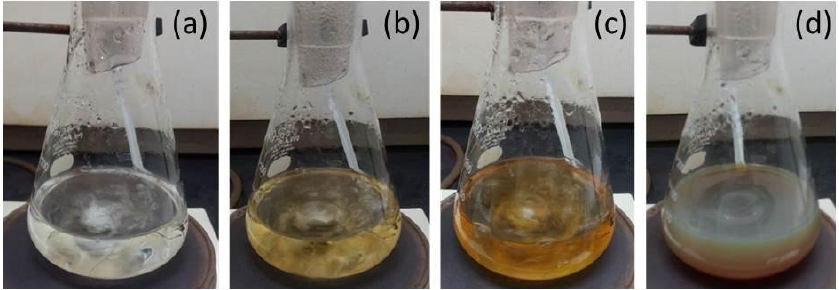
Figure 9. Color changing of sample 1 at different phases of the reaction. ( a ) Transparent color appeared on dissolving silver nitrate into the water to form silver ions at boiling temperature under continuous stirring; ( b ) light yellow color indicated the reduction of silver ions into very small silver particles after the addition tri-sodium citrate; ( c ) bright yellow color depicted the formation of larger silver particles from the smaller ones; ( d ) finally greenish yellow color revealed the completion of the reaction when all silver ions had been reduced into the elemental silver nanoparticles by the tri-sodium citrate.